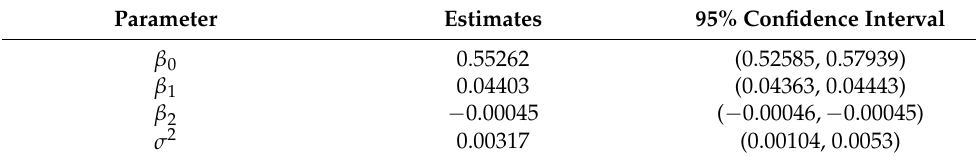
Table 1. Estimates and confidence intervals of the